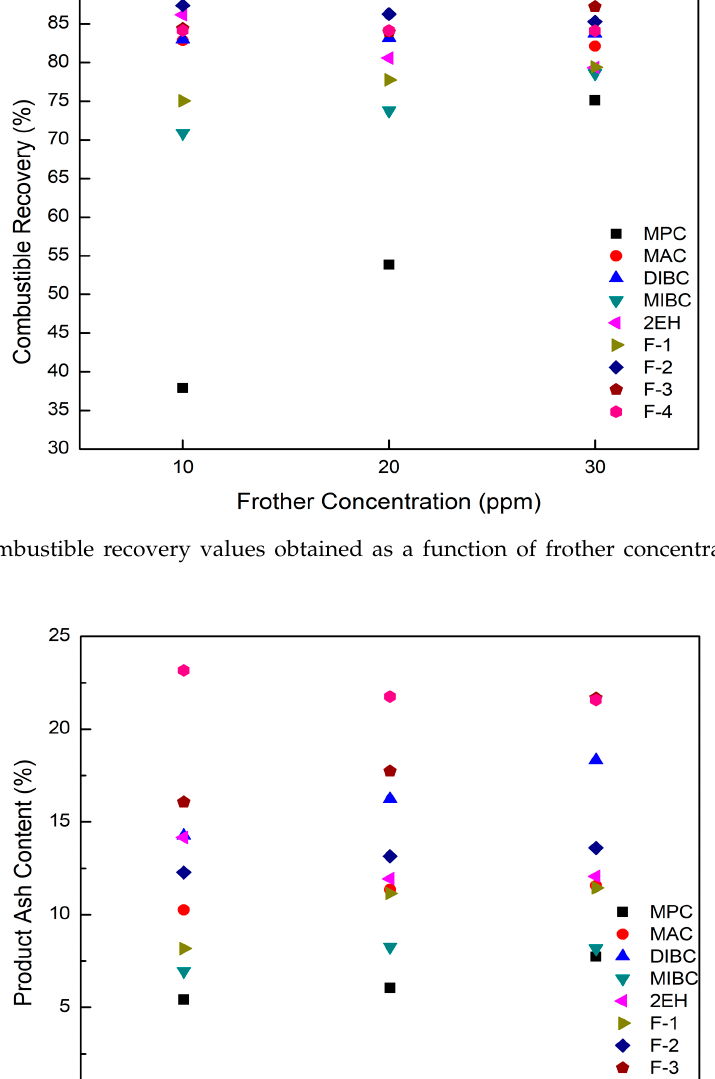
Figure 3. At a 10 ppm concentration, MPC produced relatively large bubbles and was unable to support a moderate froth depth of around 356 mm. As a result, combustible recovery values obtained using MPC was the lowest among the nine frothers with the highest value being 75% at a concentration of 30 ppm. This finding could be explained by the lowest surface tension reduction and froth depth generated per ppm of the frother (Table 4). Frothers decreased the bubble size by adsorbing at the water–air interface and reducing the interfacial surface tension. Lower surface tension values helped to reduce the bubble size, which increased the flotation rate constant (k) and thus combustible recovery. Increasing dispersion between the air bubbles through elevated electrostatic repulsion forces was another mechanism provided by frothers that results in finer bubble size distributions and enhanced flotation performance. On the contrary, the less surface-active MPC frother resulted in a large bubble size distribution and relatively low bubble-particle collision efficiencies, which yielded slow flotation rates and low flotation recovery values. The selectivity provided by the MPC frother was excellent as indicated by the proximity of the separation performances to the ideal performance (release analysis) curve in Figure 9. This finding is likely due to low water recovery and low bubble-particle attachment efficiencies, which limited recovery to the highest grade particles. Similarly, MIBC produced relatively high grade concentrates with an ash content of around 8% and low recovery values. The combustible recovery value was below 80% when using MIBC at a 30 ppm frother concentration. Dry, brittle foams were observed during the column tests with MIBC, which were not ideal optimum flotation performances. It should be noted, however, that the performances of both MIBC and MPC were comparable to